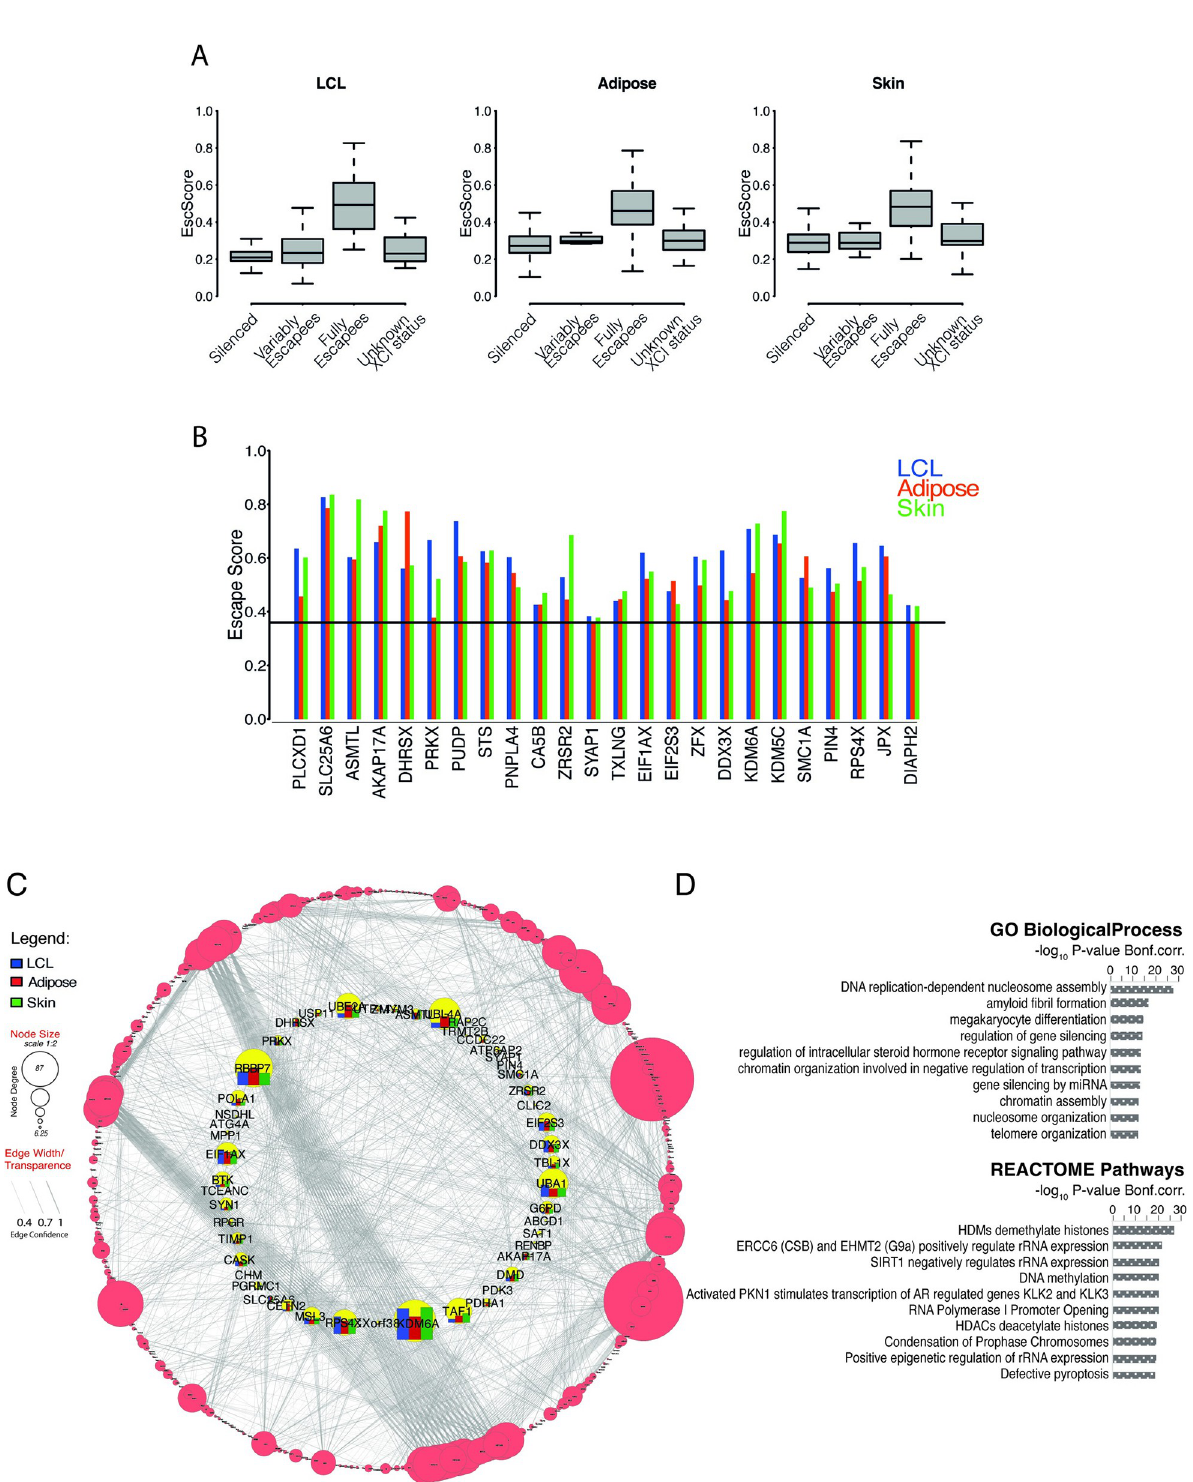
Fig 1. (A) EscScore distinguishes between silenced and escape genes. Boxplots show the distribution of median EscScore values (across skewed samples) of genes with different previously annotated XCI status [30]. (B) Genes exhibiting constitutive XCI escape in all three tissues. Barplots show the tissue-specific gene’s EscScore. Horizontal line denotes the EscScore cutoff to call XCI escape. (C-D) PPI, Gene Ontology (GO) and Pathway analysis. (C) PPI network between protein-coding X-genes escaping XCI in at least one tissue and a reference map of human proteome interactome [32]. The network inner circle shows protein-coding escape genes characterized within the proteome interactome. The bars for the genes in the inner